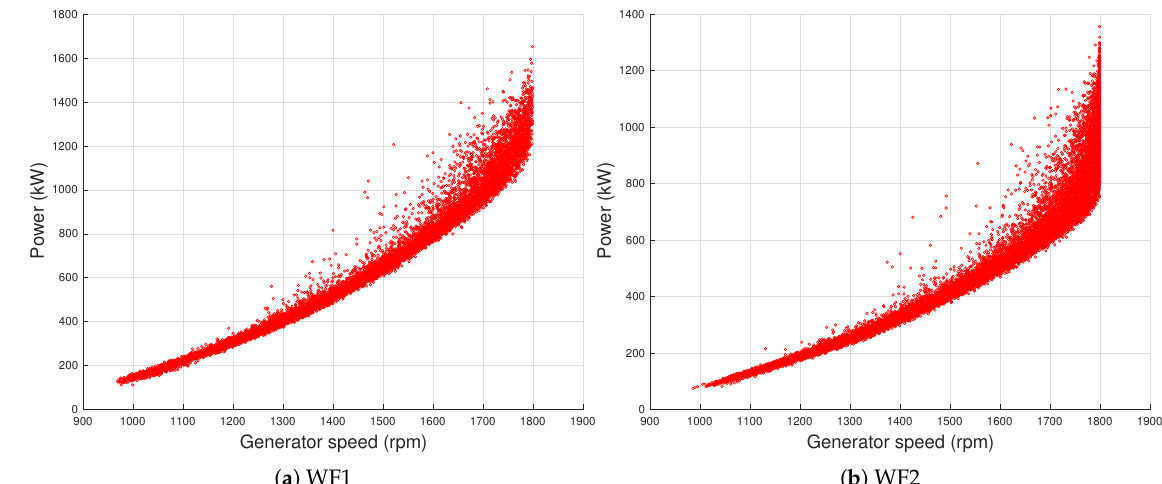
Figure 3. An example of generator speed-power curve for T1 in WF1 and WF2.